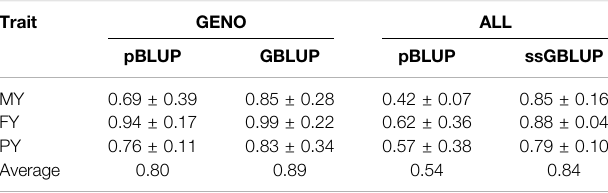
TABLE 6 | Estimated slopes calculated from breeding values from pBLUP, GBLUP, and ssGBLUP.